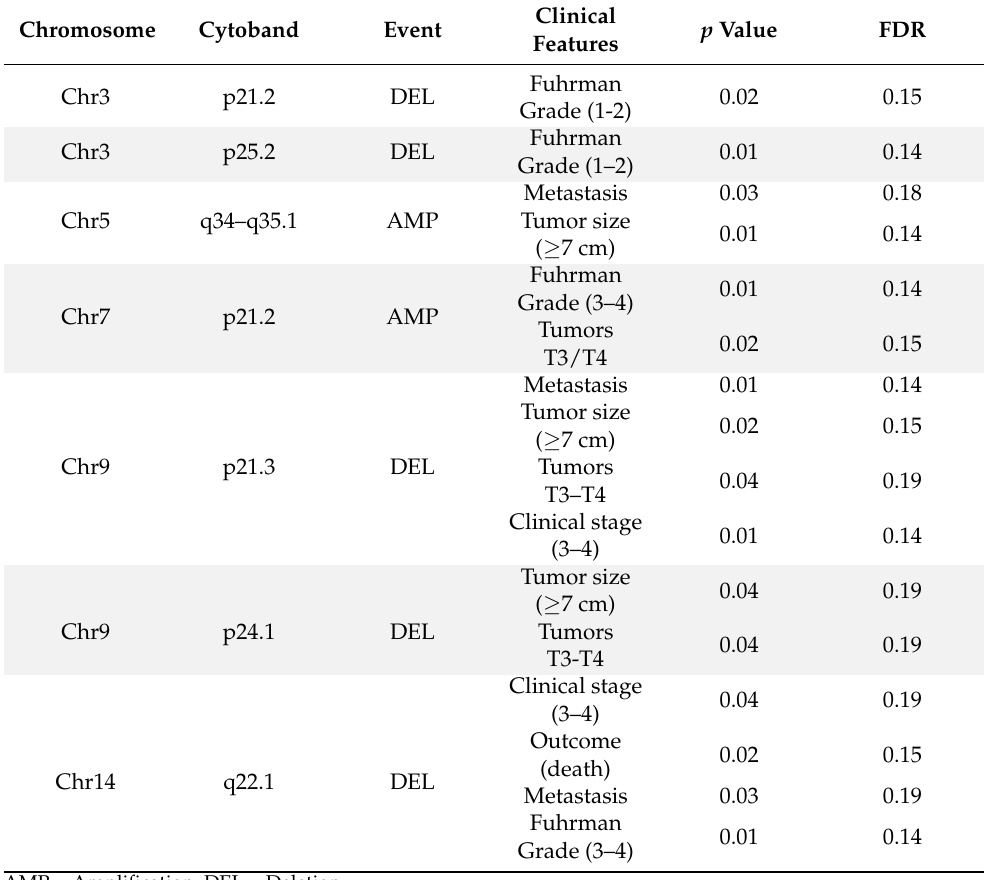
Table 3. Association of clinical features with significant regions identified by STAC.